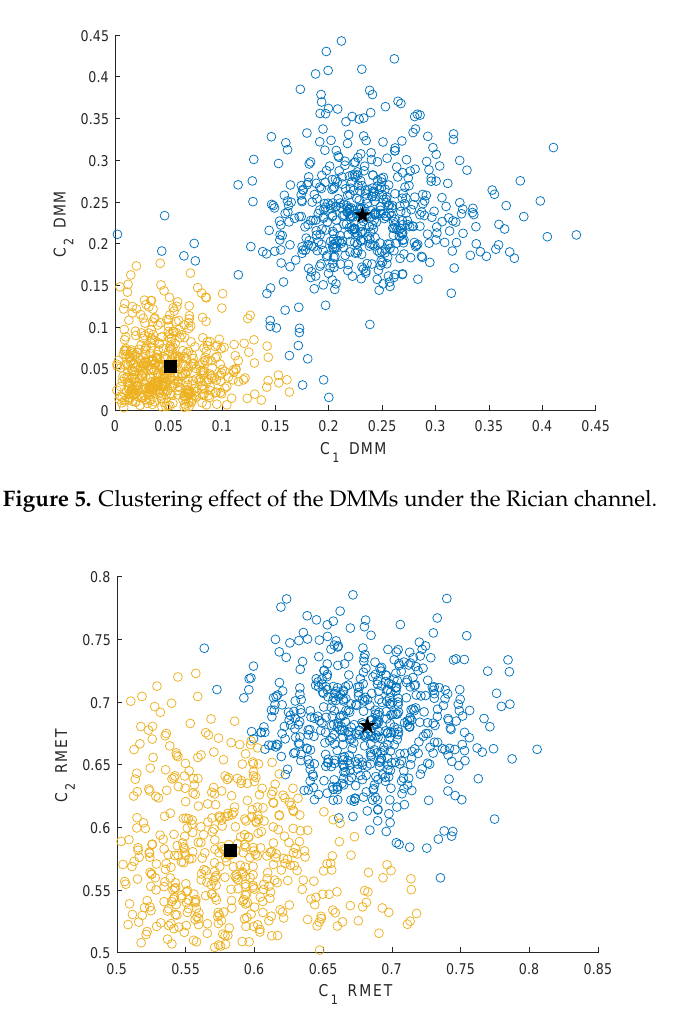
Figure 6. Clustering effect of the RMETs under the Rician